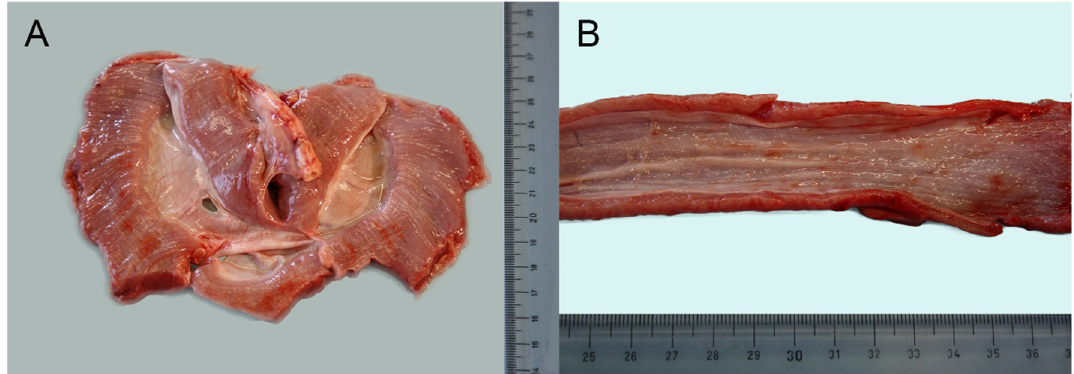
Figure 1. ( A ) Macroscopic image of diaphragm: it was severely thickened until 1 cm in section as well as the distal part of esophagus (4–5 mm thick) ( B ).